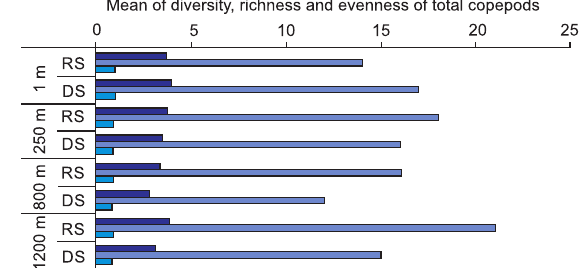
Figure 4. Vertical distribution of the mean diversity, species richness, and evenness of total copepods in the Campos Basin: dark blue bars, diversity; cobalt bars, richness; cyan bar, evenness. RS, rainy season; DS, dry